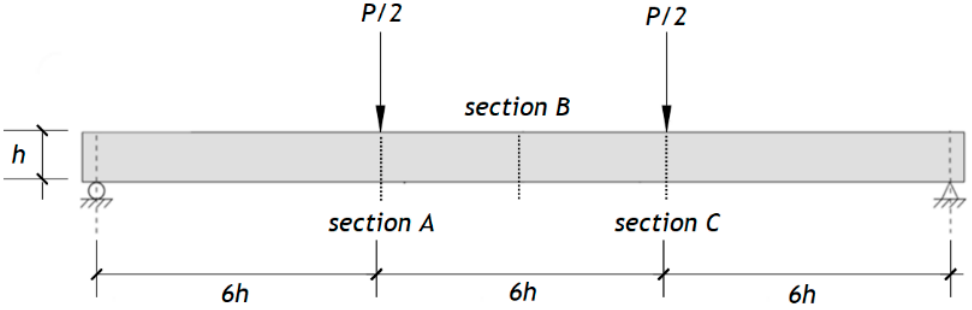
Figure 5. Setup for four-point bending.